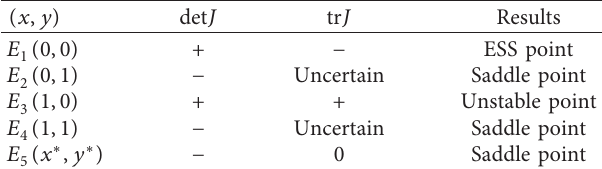
Figure 2: Phase diagram of Model II. Table 5: The stability analysis of Model III.